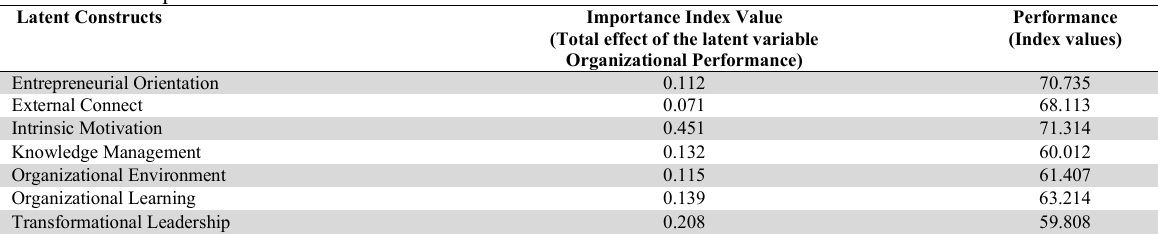
Total effects and